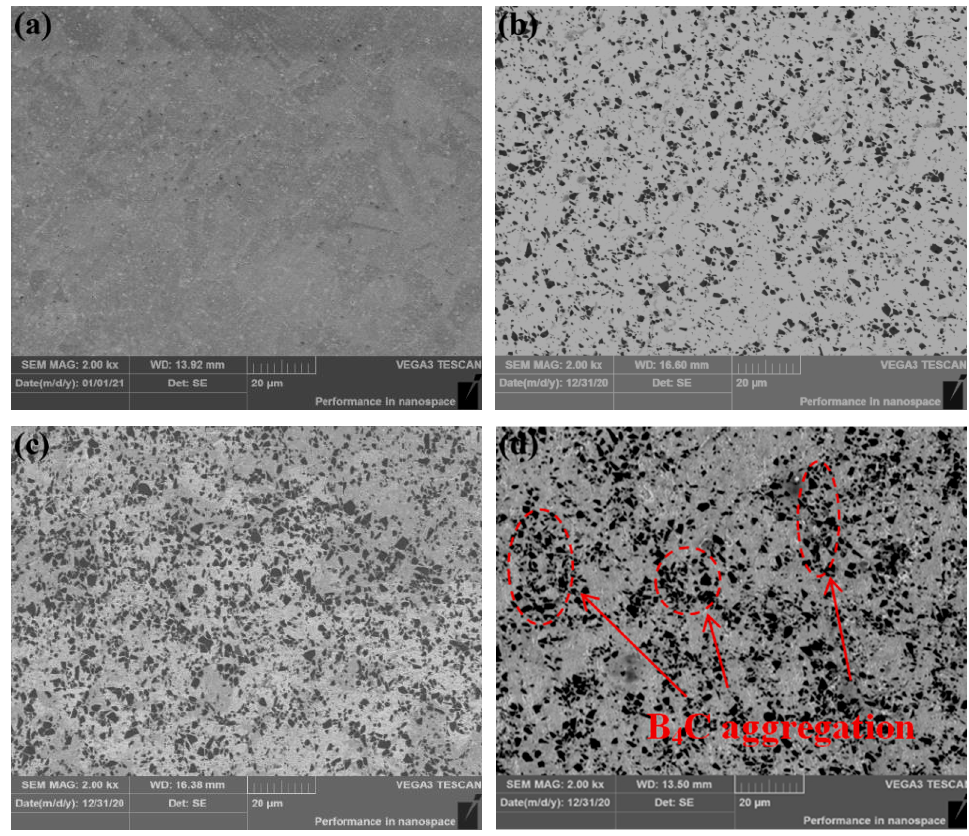
Figure 4. Morphologies of B 4 C/Cu composites under different B 4 C contents: ( a ) Cu; ( b ) Cu-5 wt.% B 4 C; ( c ) Cu-15 wt.% B 4 C; ( d ) Cu-20 wt.% B 4 C.